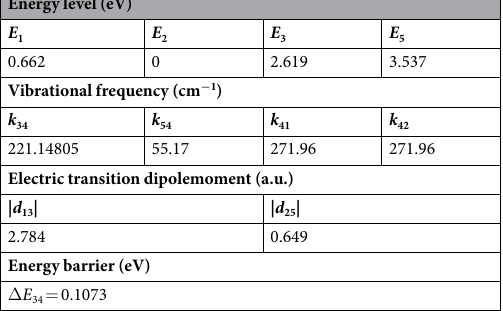
Table 2. Photo-switching properties of diarylethene (each variable listed in equations 4–11).